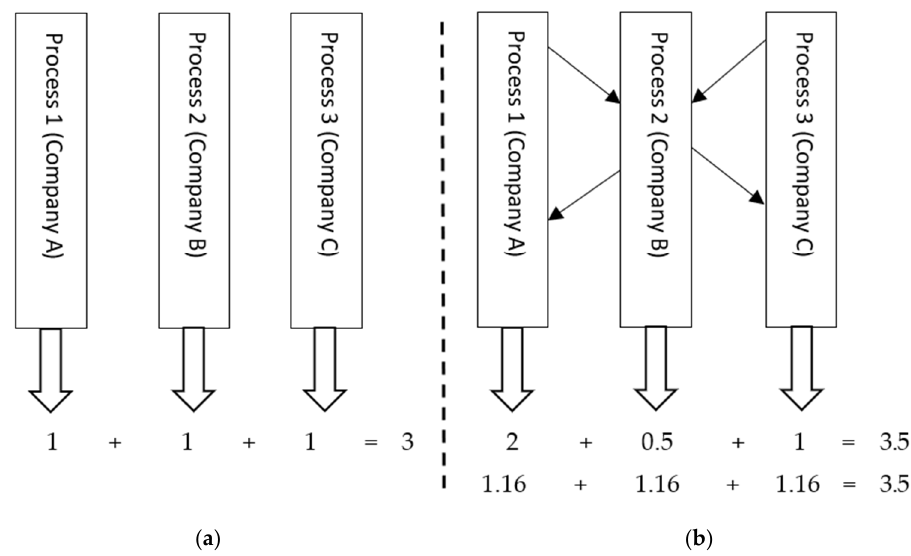
Figure 1. Example of profit from three parallel processes: In ( a ) the processes act as stand-alone units; ( b ) the processes are cooperating by sharing resources between each other.